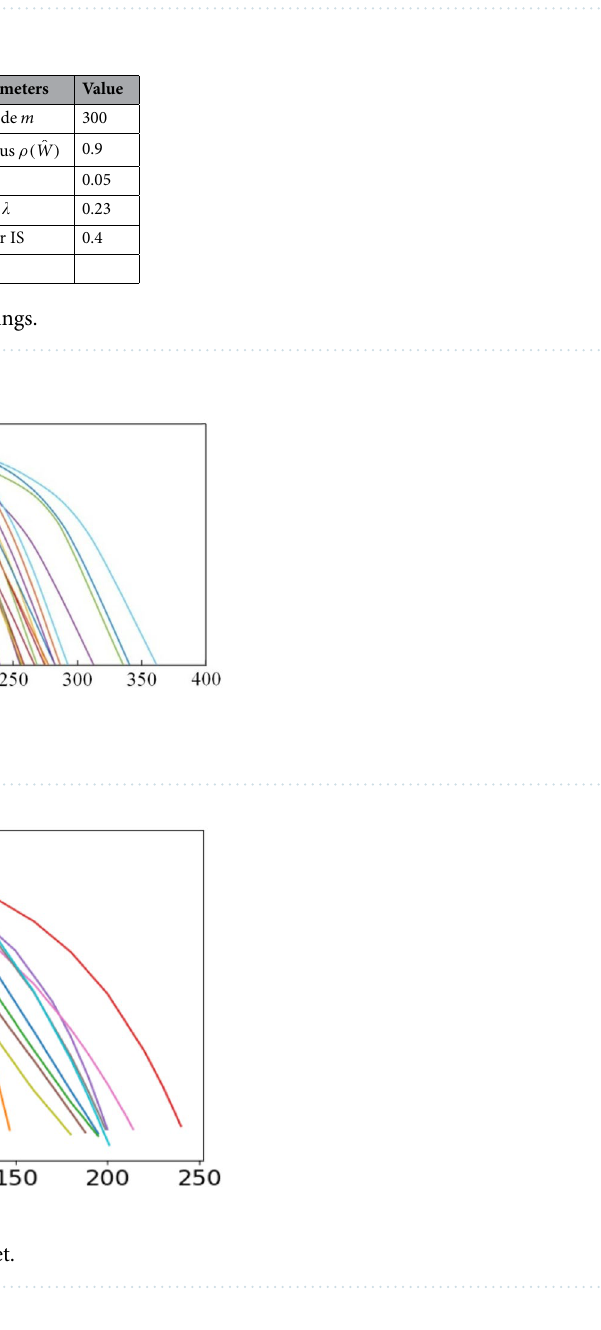
Table 2. Sensor trends summary.